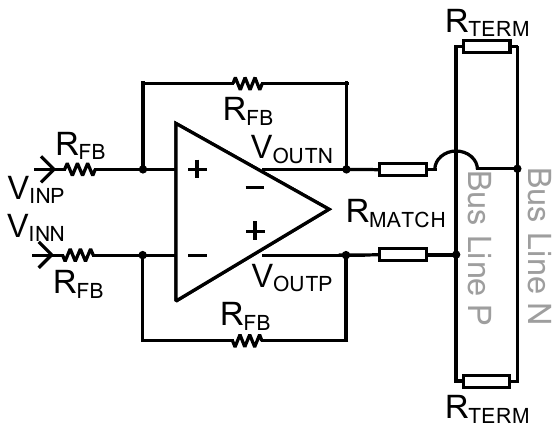
Figure 1. Architecture of a voltage-mode line driver.